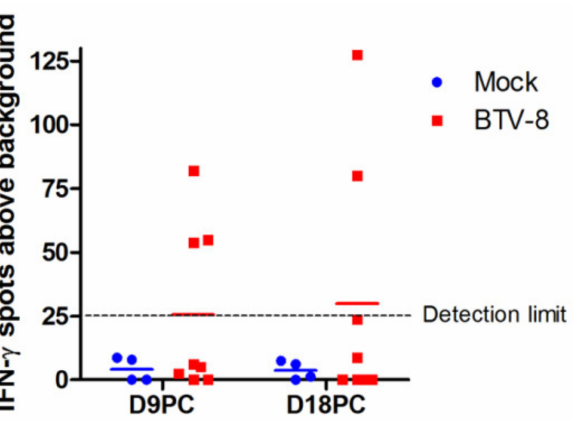
Figure 5. BTV-8 infection elicits anti-BTV IFN- γ producing cells. The presence of IFN- γ producing cells in sheep PBMC was assessed using ELISPOT assays. PBMC were stimulated with inactivated BTV-8 or mock cell lysate as negative control. All assays were performed at least in triplicates. Data are presented as average IFN- γ spots above background for 1 × 10 6 PBMC at the indicated timepoint (D9PC: day 9 post-challenge; D18PC: day 18 post-challenge). The dotted line indicates the detection limit of the assay. IFN- γ producing cells to BTV-8 were detected in 3 out of 8 infected sheep at D9PC and in 2 sheep out of 8 infected sheep at D18PC. No specific IFN- γ responses were detected in PBMC from mock-infected sheep. Detailed ovine IFN- γ ELISPOT methods can be found in Supplemental File S1 and in